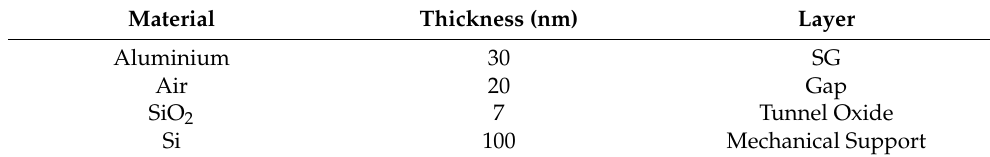
Figure 4. Doubly–clamped beam structure used to analyse dynamically the pull–out effects through FEM–based software. Table 1. Set of parameters used to numerically analyse the pull–in and pull-out voltages. Table 1. Set of parameters used to numerically analyse the pull-in and pull-out voltages.